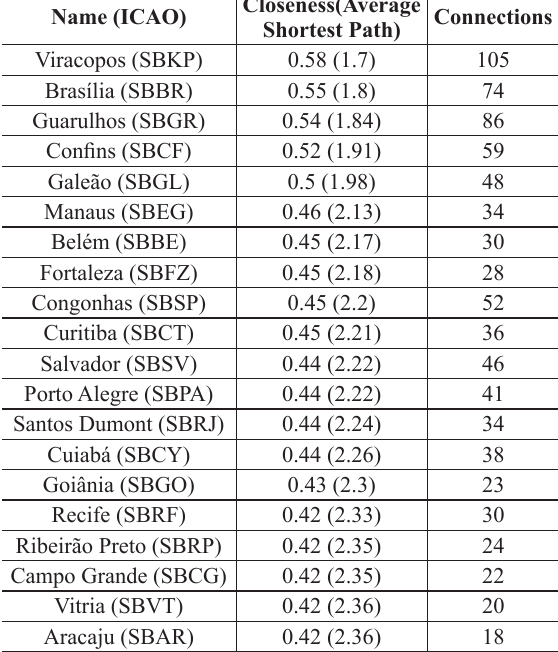
Top-20 Airports - Highest Closeness Centrality - National